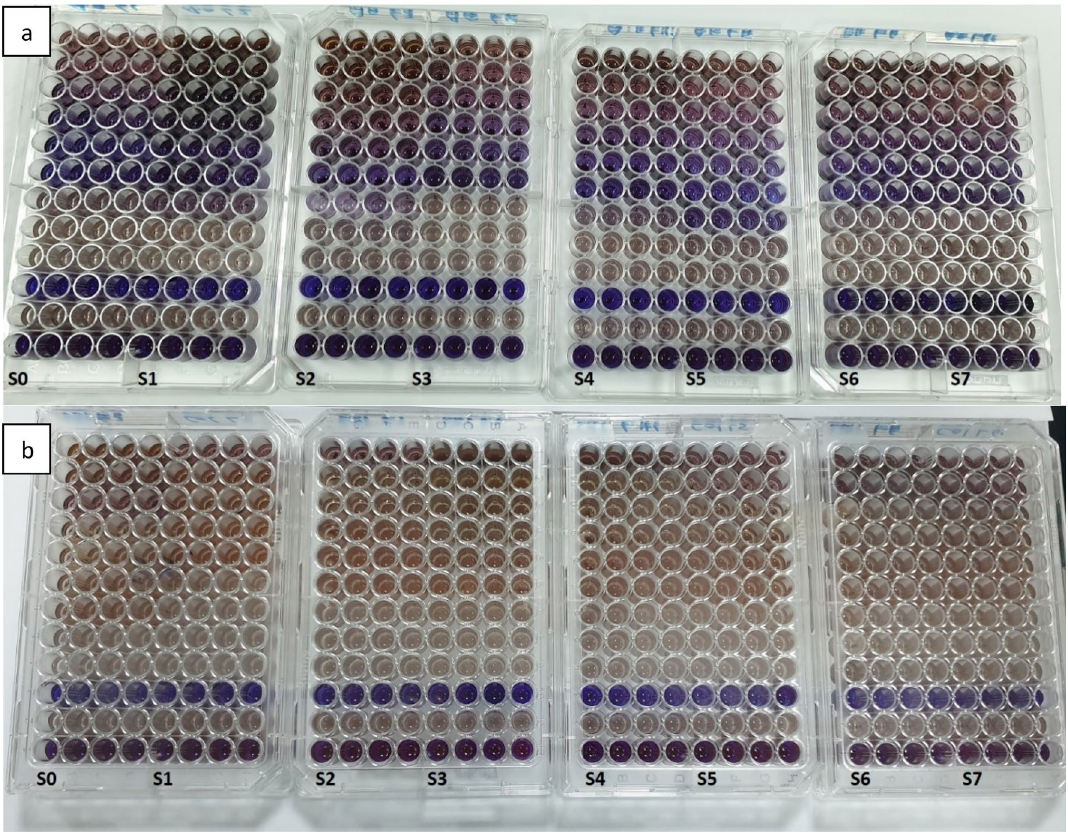
Figure 3. MICs of PJ-WS-LE extracts prepared using P. juliflora leaves collected from different locations in Qatar against A. alternata ( a ) and C. gloeosporioides ( b ). S0: old extract from the laboratory. S1 to S7: extract prepared using leaves of sample S1 to S7. Rows 1 to 9 contains the following concentrations of PJ-WS-LE extract in g L −1 : 42, 21, 10.5, 5.2, 2.6, 1.3, 0.6, 0.3 and 0.16. Row 10 contains no spores, row 11 contains no extract and row 12 contains 1%